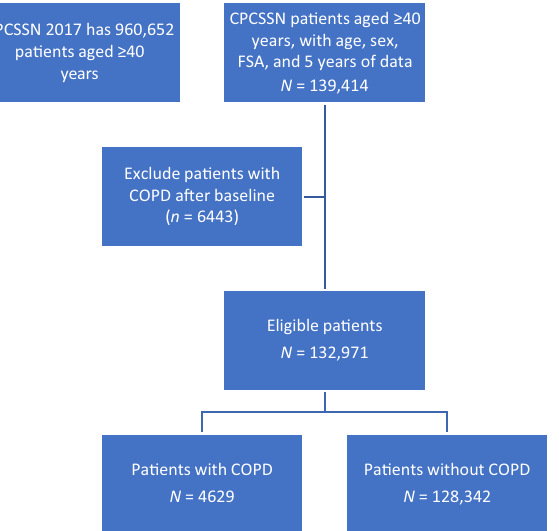
Fig. 1 Derivation of Data for Analysis. Canadian Primary Care Sentinel Surveillance Network (CPCSSN), FSA (Forward Sortation Area), COPD (Chronic Obstructive Pulmonary Disease). Data avail- able for analysis.